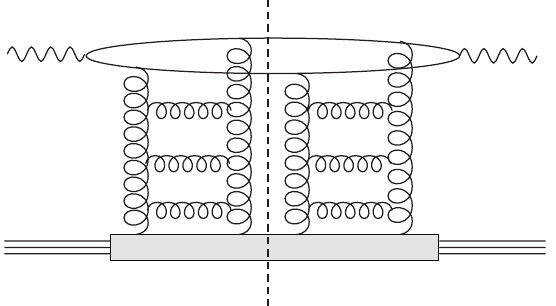
Figure 2: The diffractive DIS cross section via double ladder